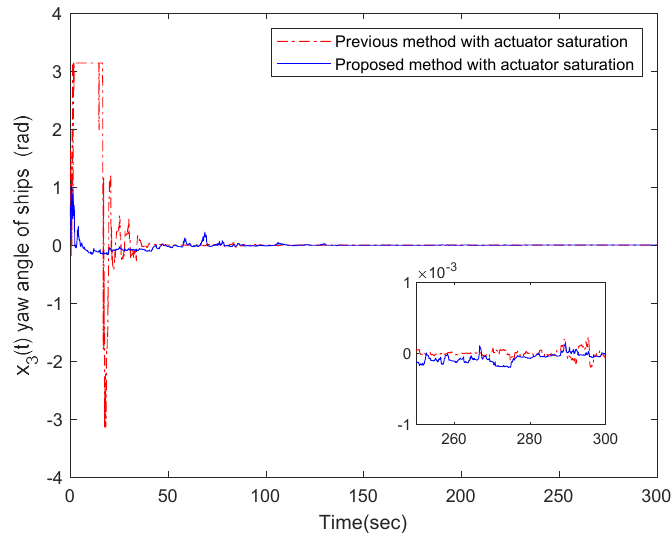
x t compared with [29]. 3